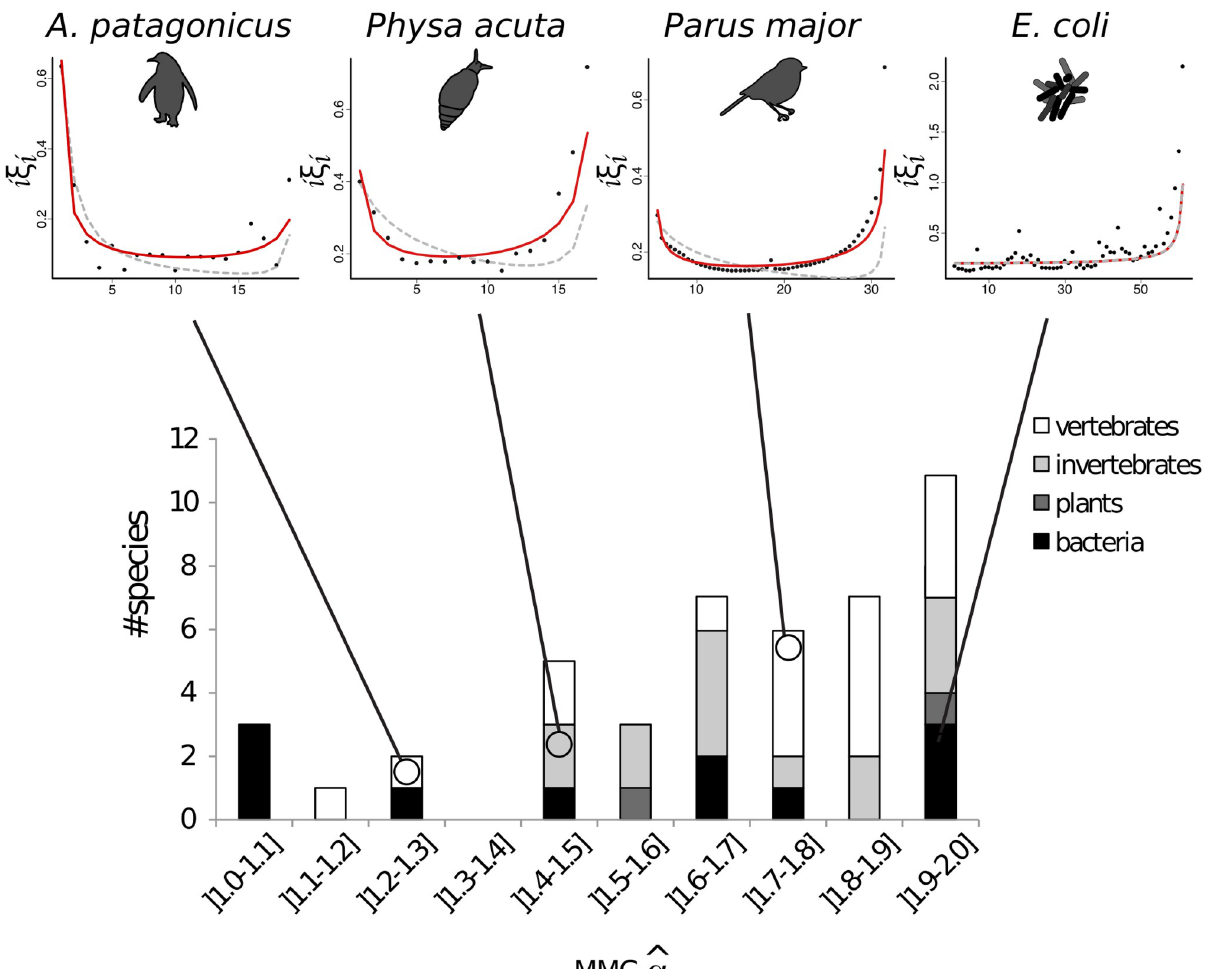
Fig 2. Estimates of α by species. The four top panels represent transformed ϕ -SFS ( ϕ i = iξ i as in [54, 55]) for four species from different taxa: two vertebrates Aptenodytes patagonicus (left) and Parus major (center right) an invertebrate Physa acuta (center left), and a bacteria Escherichia coli (right). For E. coli , the uptick in the spectrum comes exclusively from the allele miss-orientation, as ^ a ¼ 2 . Black dots are the observed values, grey dotted lines are the best fits under the Kingman’s coalescent model and red lines are the best fits under a Beta-coalescent model.